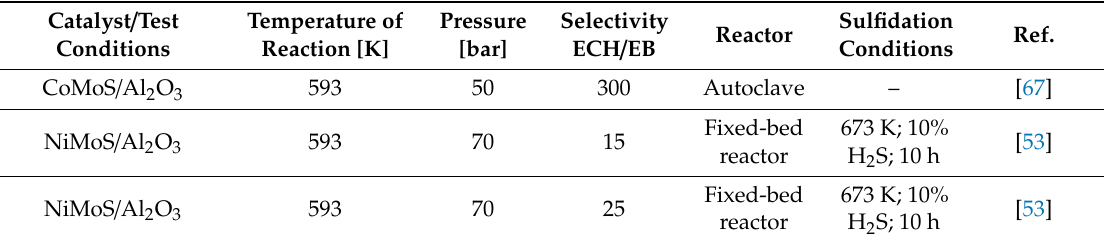
Table 3. Selectivity between route #1 and #2 over di ff erent catalysts tested in HDN of indole. Data from literature compared with the results reported